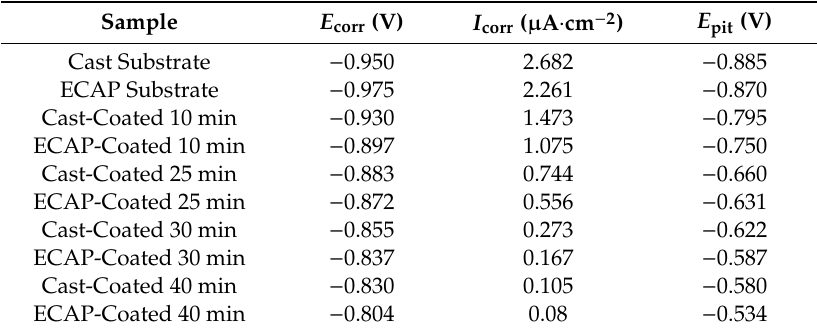
Table 2. Electrochemical parameters of the coated and substrate samples obtained from the potentiodynamic polarization (PDP)